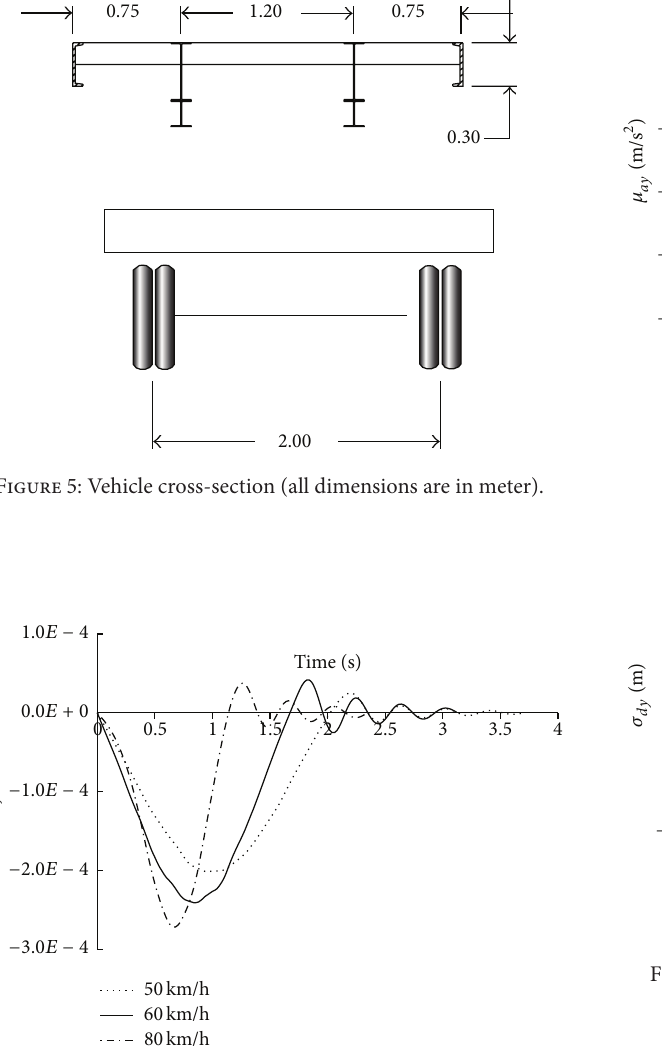
Figure 6: Mean displacement of bridge at the midspan.